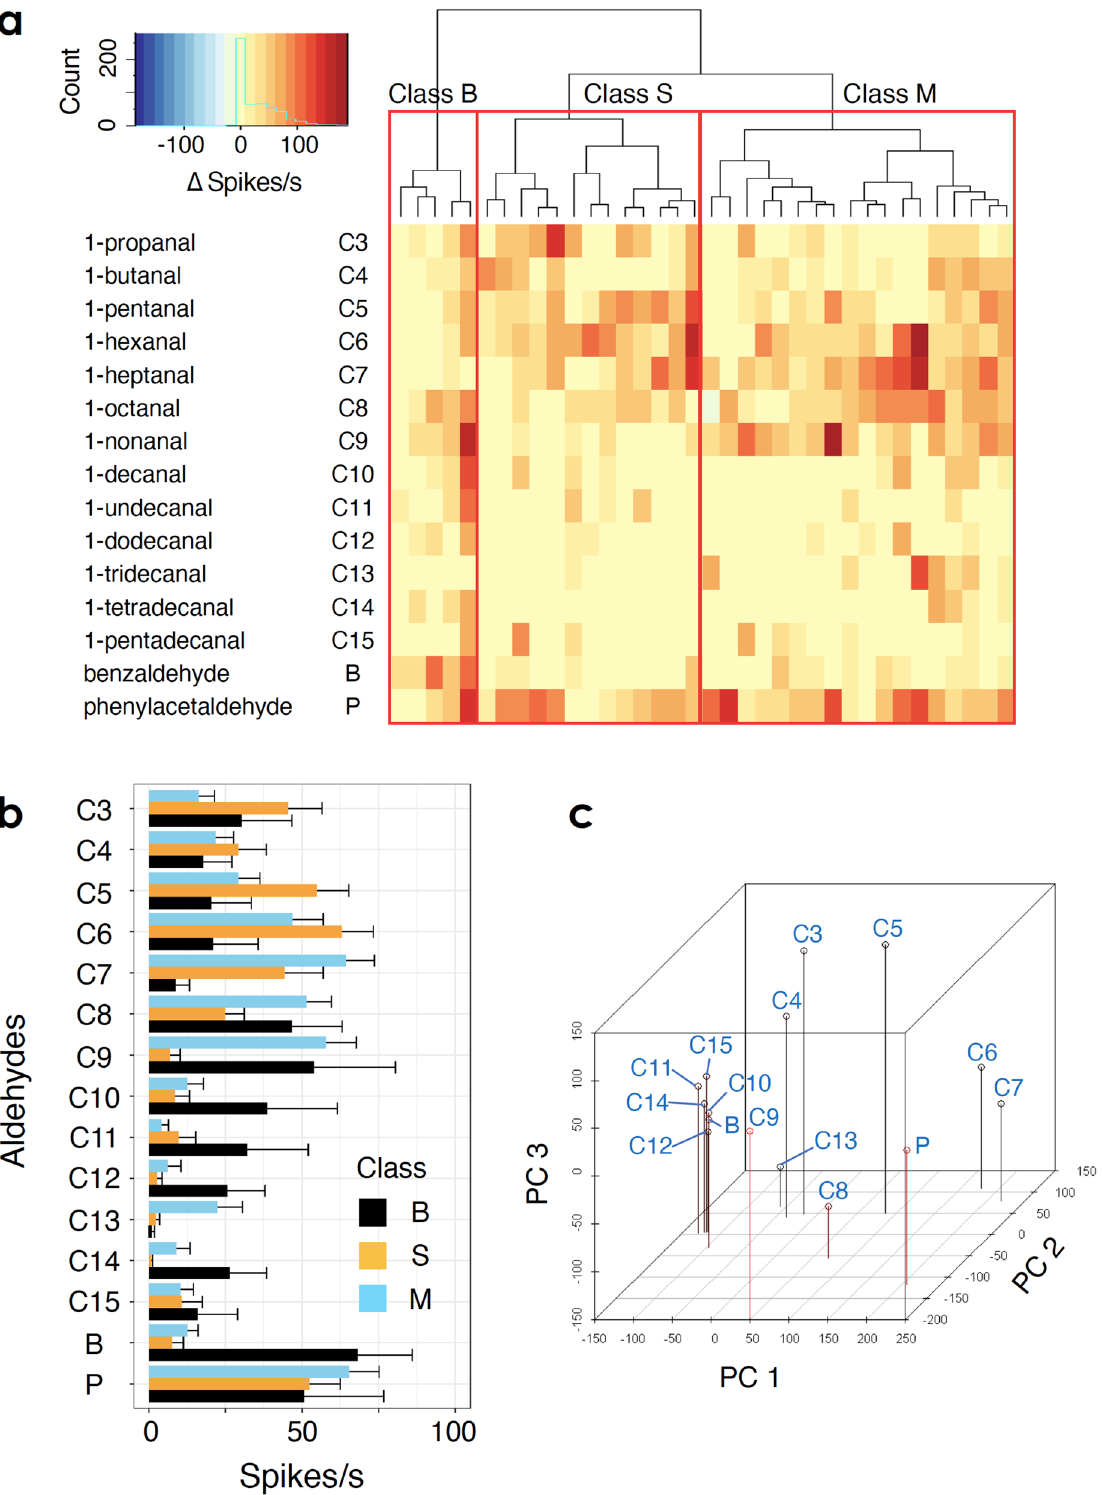
Figure 3. ( a ) A heat map of the response intensities of a single OSN to tested aldehydes. Each column indicates a single OSN showing a unit 3-type spike. A dendrogram of a hierarchical cluster analysis (shown above the heat map) suggested three classes: B, S, and M. Class B OSNs broadly responded to most aldehydes, including benzaldehyde. Class S and M responded strongly to short (C3–C7) and middle-length chain (C6–C9) aldehydes, respectively. The distance was defined as 1 − r (correlation coefficient). ( b ) Mean responses of classes B (black), S (orange), and M (sky blue) to aldehyde odours. Error bars indicate standard error. See the heat map ( a ) for abbreviations of aldehydes. c The first three principal components (PC1–3) of an OSN space that correlate aldehydes with the OSNs that they activate. R 3.6.1 software (https ://www.r-proje ct.org/) was used for